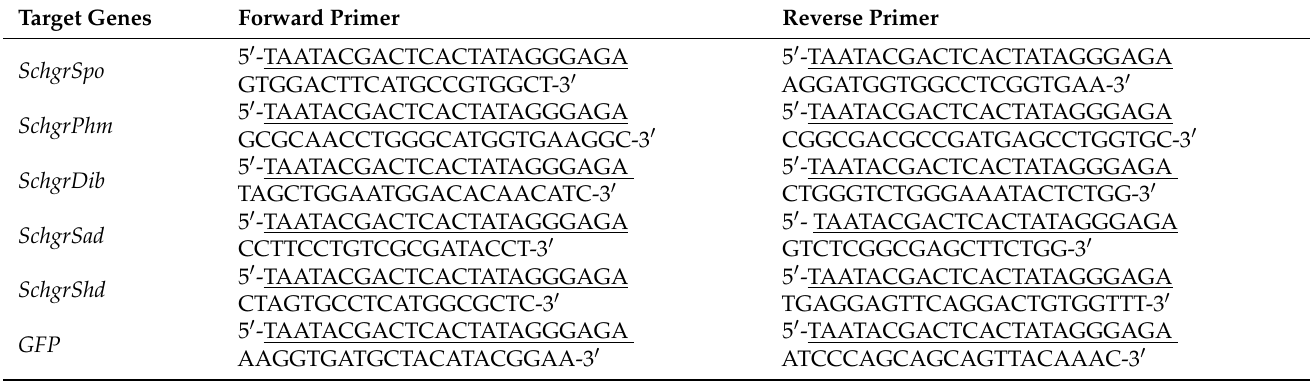
Table A2. Oligonucleotide sequences of primers used for dsRNA construct design. Underlined sequences are the T7 promoter